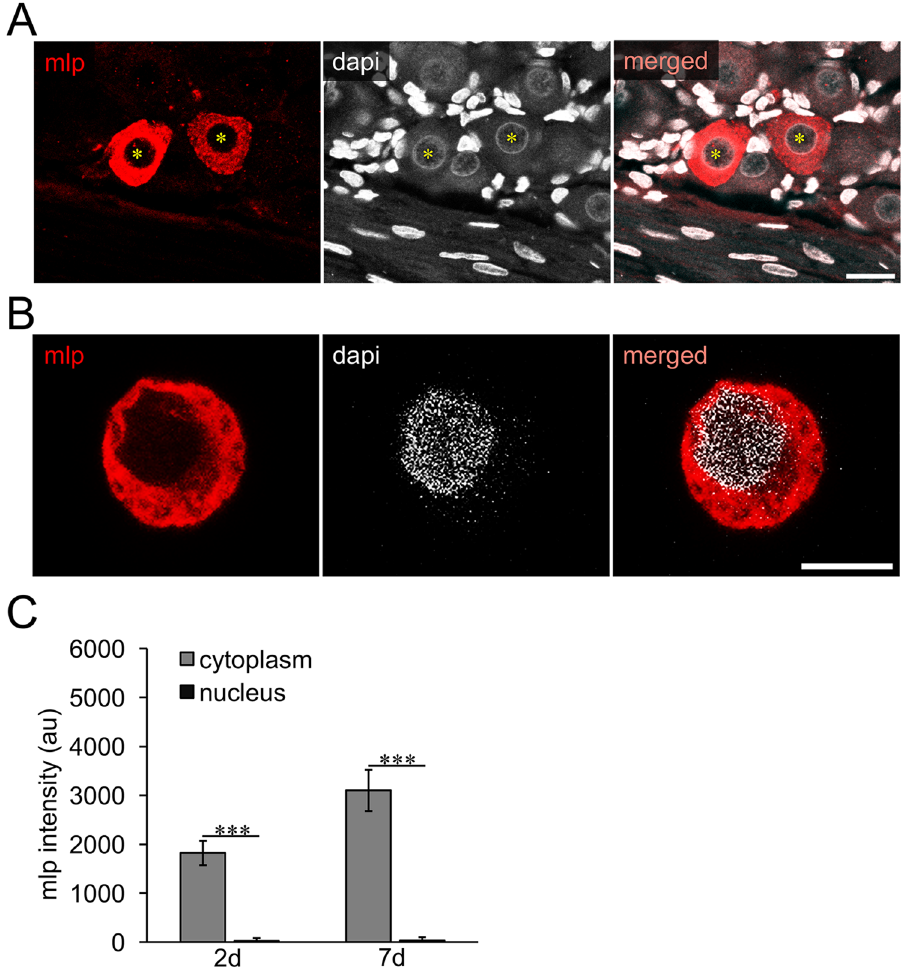
Figure 2. MLP is located in the cytosol, but not the nucleus. ( A ) Confocal images (4 merged z-stacks of 1.04 µ m each) of MLP (red) and DAPI (white) stained DRG section 7 days after sciatic nerve crush. MLP was detected in the cytoplasm, but not in DAPI-positive nuclei of DRG neurons (stars). Scale bar: 20 µ M. ( B ) Confocal image (3 merged z-stacks of 0.956 µ m) of a MLP (red) and DAPI (white) stained DRG neuron after 3 days in culture. MLP was not detected in nuclei of cultured DRG neurons. Scale bar: 10 µ M. ( C ) Intensities of MLP signals were quantified on confocal images 2 and 7 days after sciatic nerve crush stained as described in ( A ) in nuclei and cytoplasm of MLP-positive neurons. Data are indicated in arbitrary units (au) for background-corrected fluorescence intensities. Effects: *** p <